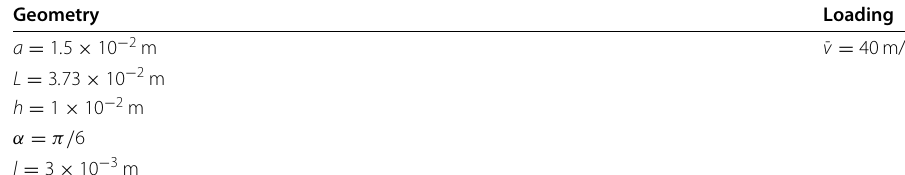
Table3 Parameters of the double-notched specimen test case Geometry Loading